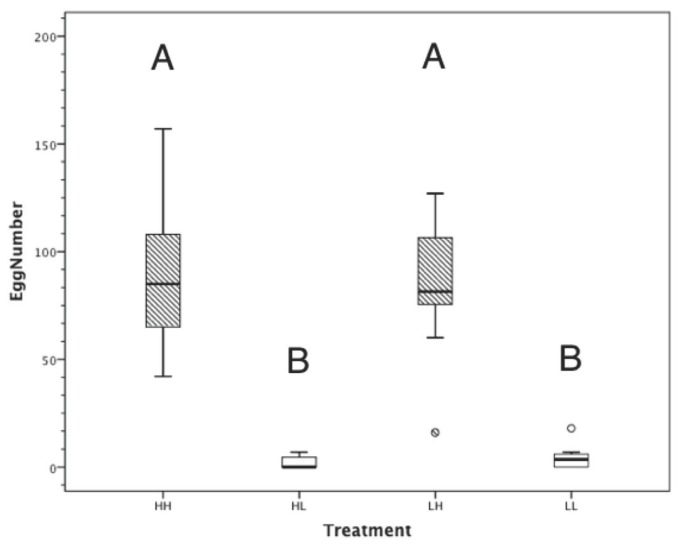
Feeding treatment and female fecundity.The females on high adult feeding treatments (A, n = 25) produced significantly more eggs than the females on low adult feeding treatments (B, n = 24), however, juvenile feeding treatment had no effect on fecundity. The horizontal line of box-plots represents the mean value for fecundity, the upper and lower boundaries of the box are the 75th and 25th percentiles and the bars represent the 90th and 10th percentiles.